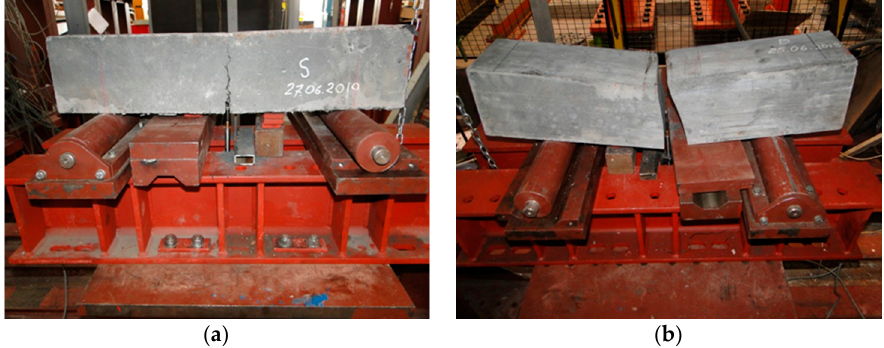
Figure 5. Specimens during the flexural strength test ( a ) and when failed ( b ).